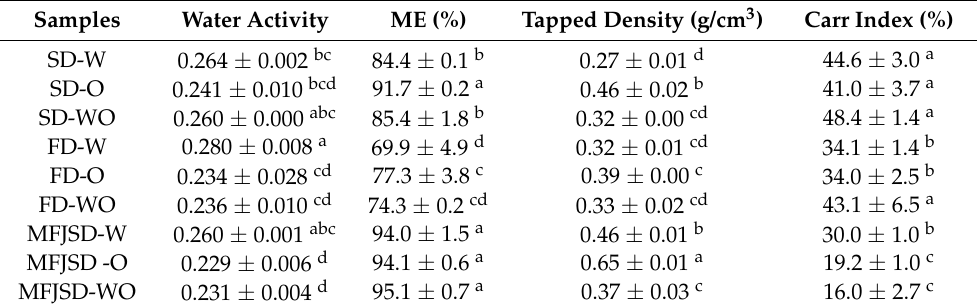
Table 1. Physicochemical properties of